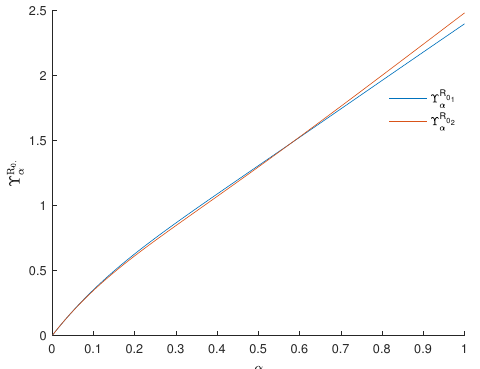
Figure 3. Evolution of the sensitivity index for the basic reproduction numbers of both communities, R 01 and R 02 , with the variation of the derivative order, α